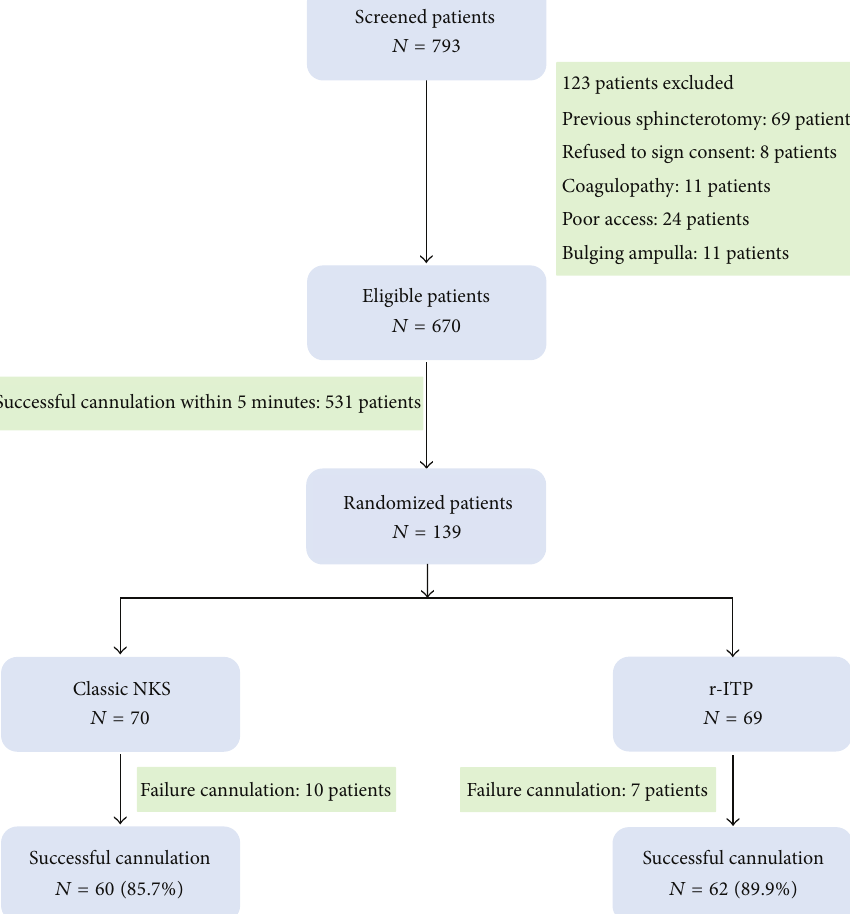
Figure 3: (Flowchart) Distribution of screened, excluded, and randomized patients in the